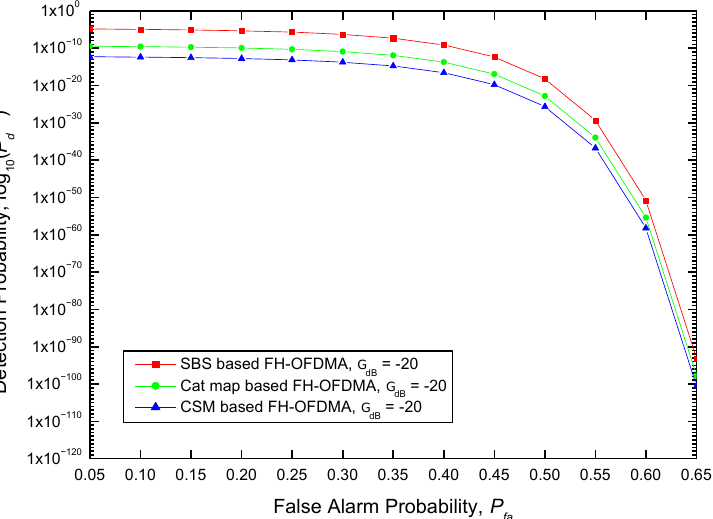
Figure 6. Required false alarm probability versus detection probability compared to SBS, cat map, and CSM-based FH-OFDMA